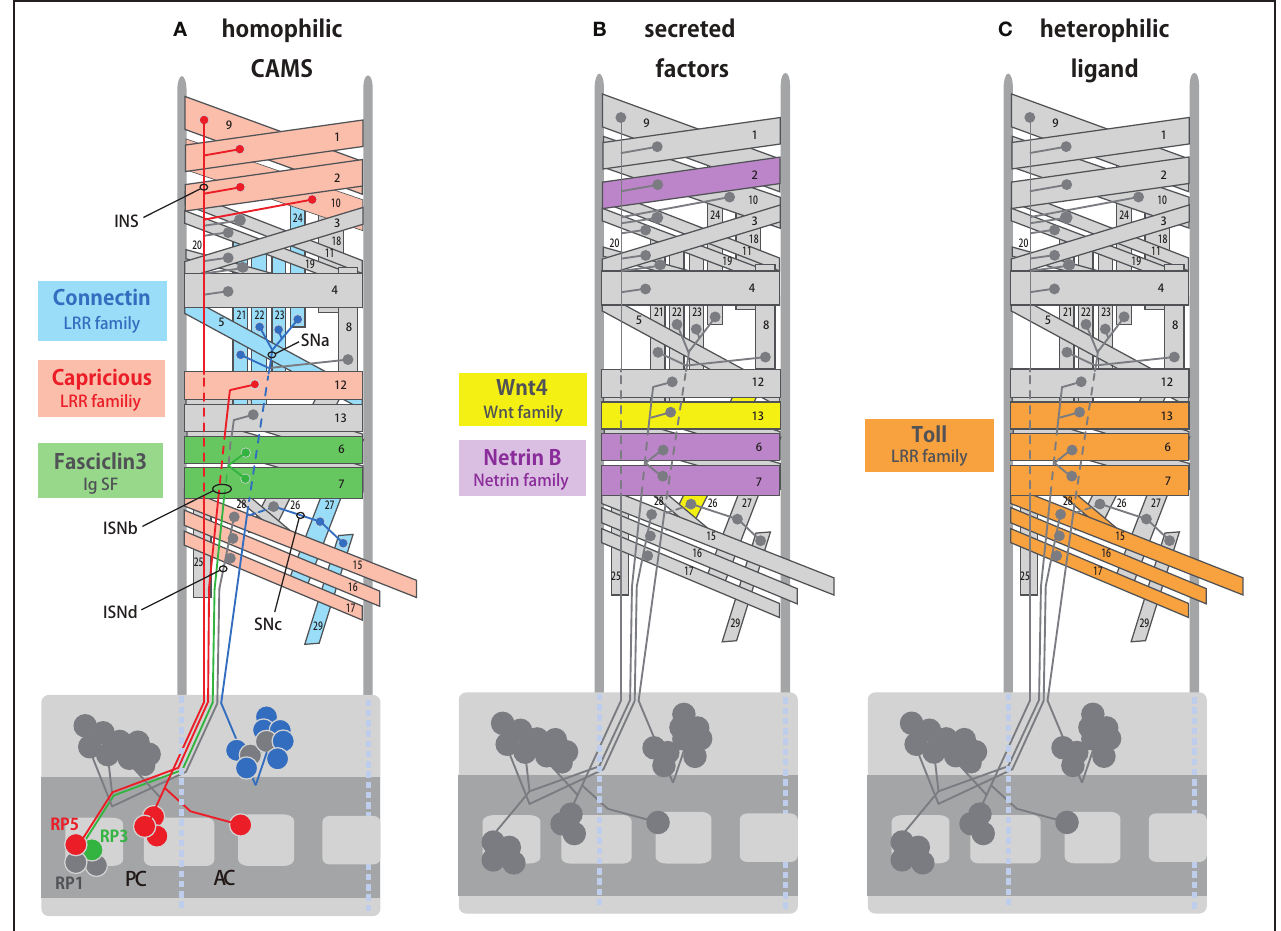
FIGURE 1 | Expression of target recognition molecules in specific muscles and motor neurons. (A) Expression of hemophilic cell adhesion molecules, Fas3, Capricious (Caps), and Connectin (Con) in specific synaptic partners. Fas3 is expressed in the RP3 motor neuron and its target muscles M6/7 ( green ). Caps is expressed in the RP5 motor neurons and its target M12 ( orange ). Con is expressed in external muscles and a group of motor neurons that innervate them ( blue ). (B) Expression of